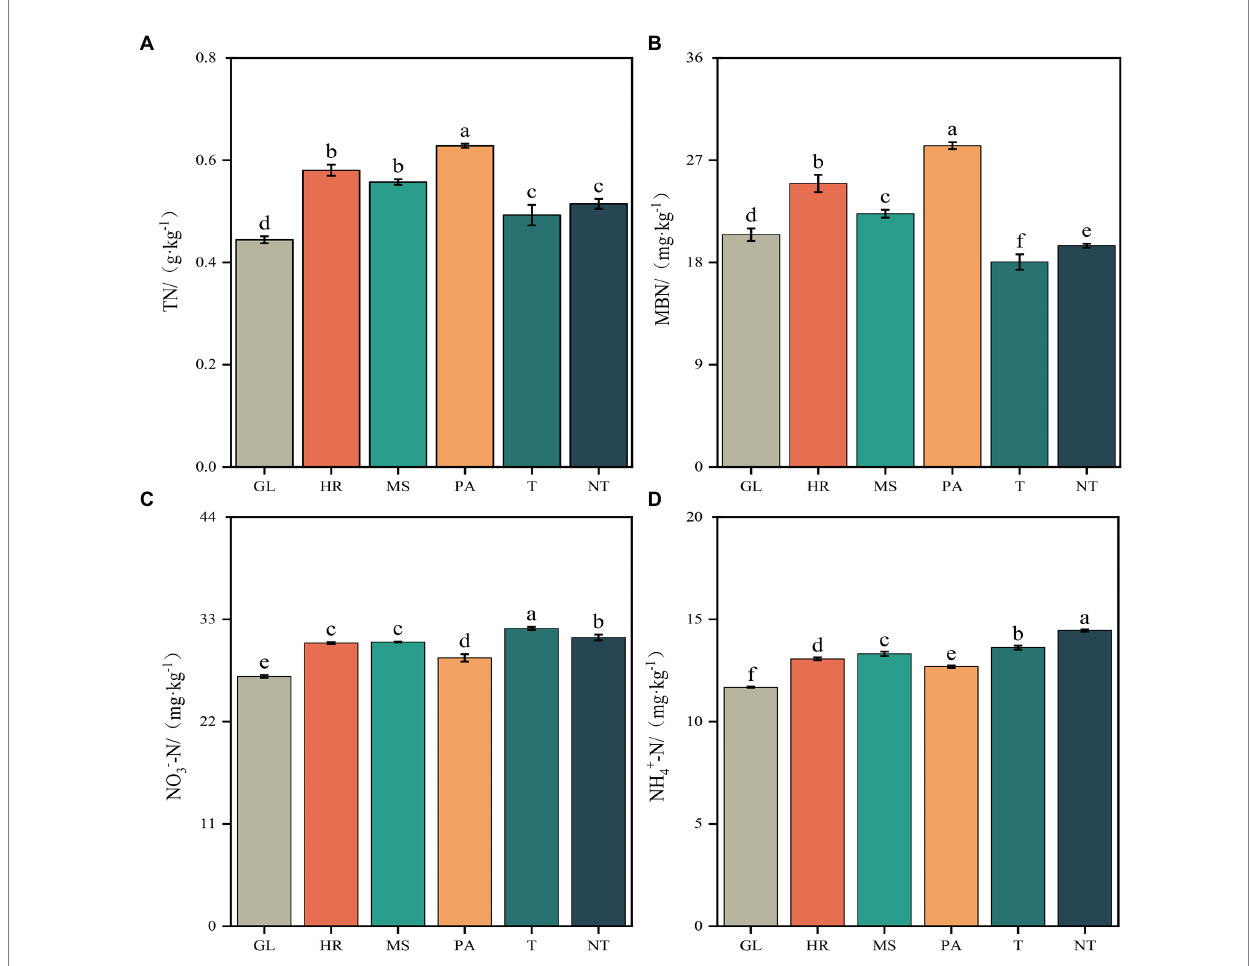
FIGURE 4 Changes in soil nitrogen composition under different land use patterns. Response of soil nitrogen contents to different land use patterns. Vertical error bars represent the standard error of mean values. Different lower-case letters show significant differences between different treatments at p < 0.05. Panel (A) is the soil total nitrogen values as influenced by the land use patterns. Panel (B) is the microbial biomass nitrogen under different land use patterns. Panel (C) is the nitrate nitrogen under different land use patterns. Panel (D) is the ammonium nitrogen as affected by the different land use